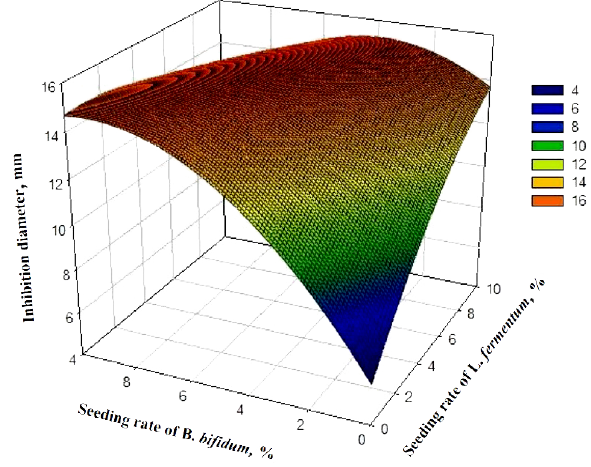
Figure 4 Response surface model of inhibition zone Figure 5 Response surface model of inhibition zone of Lactobacillus fermentum and Bifidobacterium bifidum of Lactobacillus fermentum and Bifidobacterium bifidum against Salmonella sp. with seeding rates of Lactobacillus against Escherichia coli with seeding rates of Lactobacillus fermentum ( X ) and Bifidobacterium bifidum ( X ), fermentum ( X ) and Bifidobacterium bifidum ( X ), 1 2 1 2 incubation temperature ( X ), and incubation time ( X ) at incubation temperature ( X ), and incubation time ( X ) 3 4 3 4 temperature 0 (39.5°C) and time 0 (24 h) at temperature 0 (39.5°C) and time 0 (24